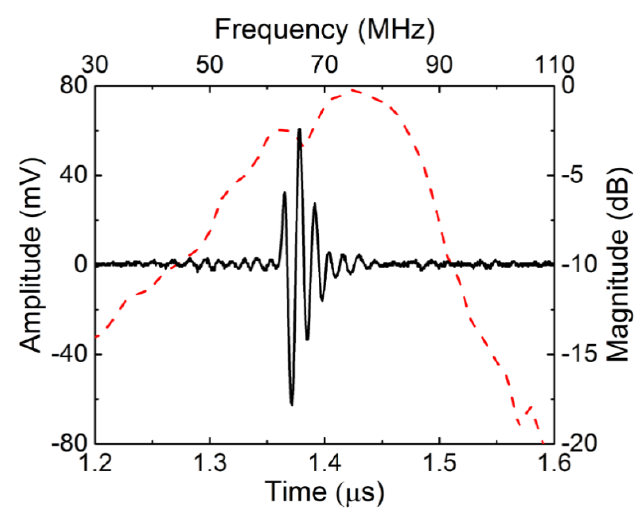
Figure 5. Time-domain pulse/echo response and normalized frequency spectrum of Co-doped Na 0.5 Bi 4.5 Ti 4 O 15 (NBT-Co) transducers.